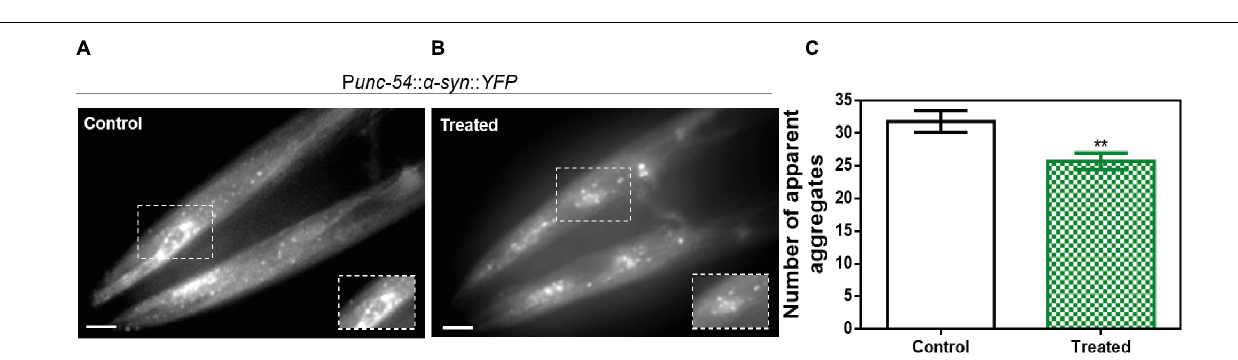
FIGURE 8 | In vivo anti-aggregational assays in Caenorhabditis elegans . Representative images of apparent α -Syn aggregates in C. elegans body wall muscle cells obtained by epifluorescence microscopy of NL5901 worms treated without (A) and with ZPD-2 (B) . (C) Quantification of α -Syn muscle inclusions in the absence (white) and presence of ZPD-2 (green). ∗∗ p <